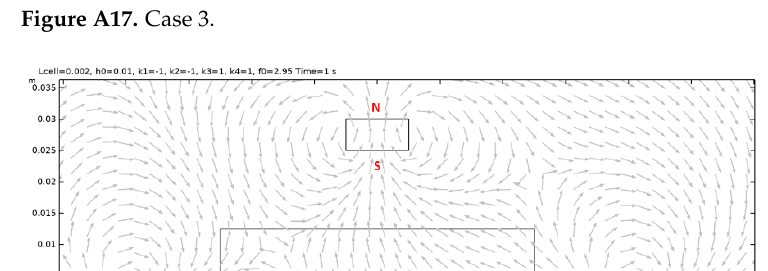
Figure A17. Case 3. Figure A17. Case 3.